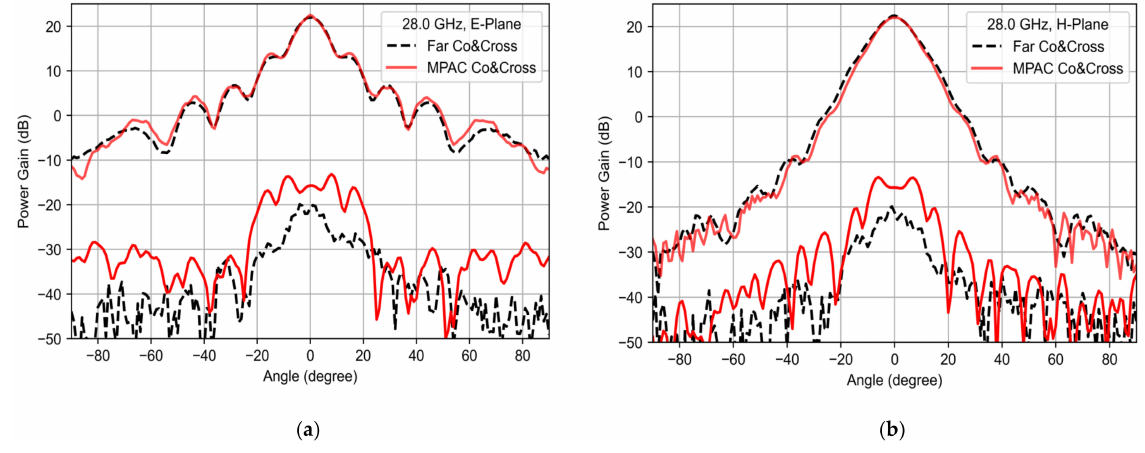
Figure 10. Radiation patterns of standard gain horn antenna at 28 GHz. ( a ) E-plane. ( b ) H-plane.